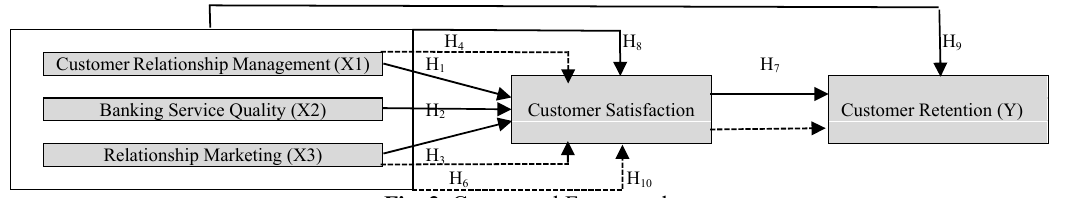
Fig. 2. Conceptual